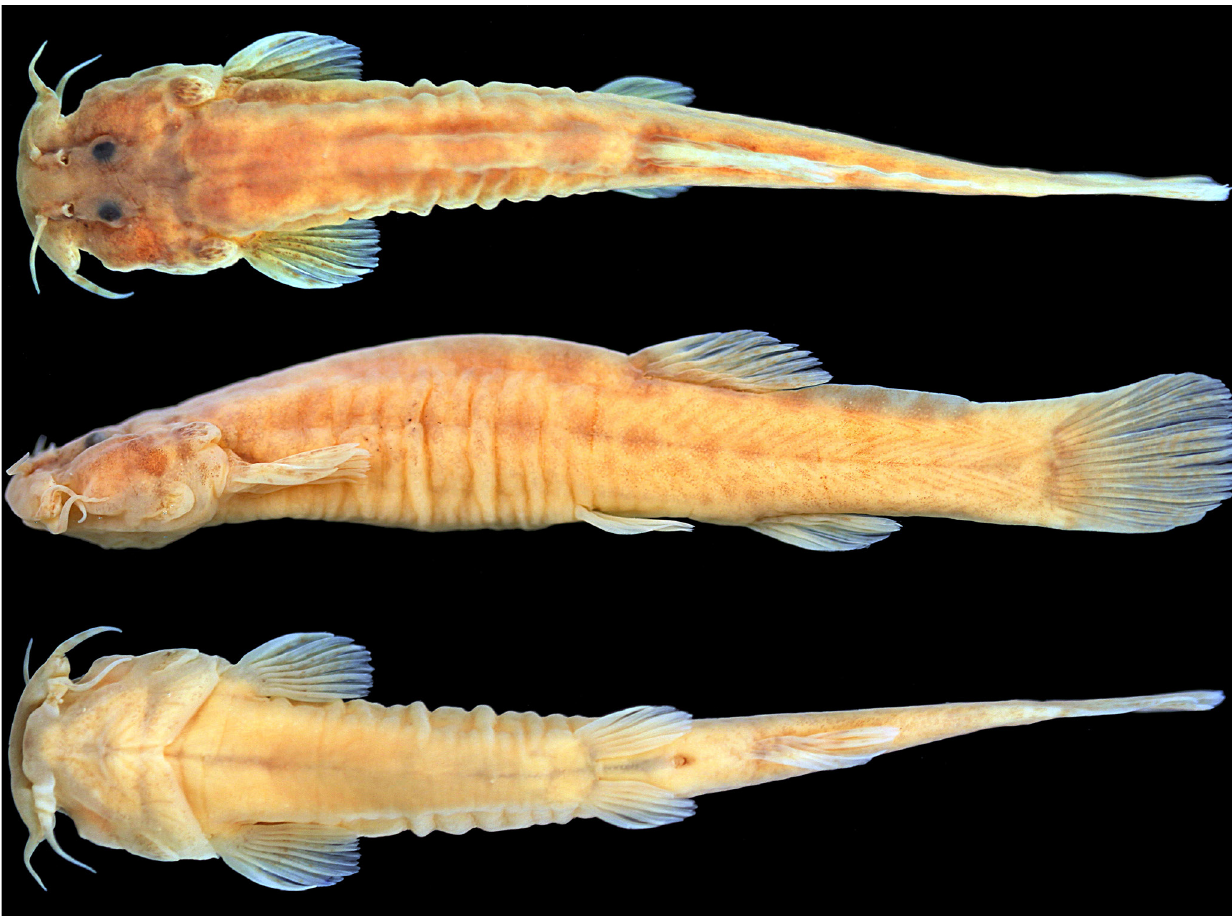
FIGURE 12 | Scleronema mate , new species, holotype (MCP 54183; 49.3 mm SL), Brazil, Rio Grande do Sul, Venâncio Aires, arroio Grande, tributary of arroio Castelhano, rio Taquari basin, laguna dos Patos